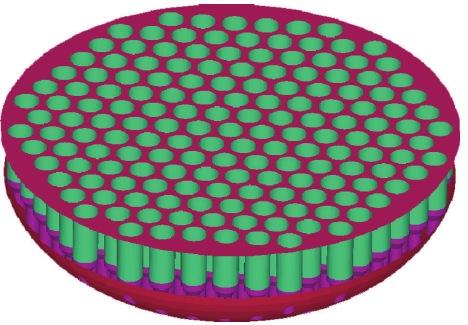
Figure 4: Lower plenum structures.